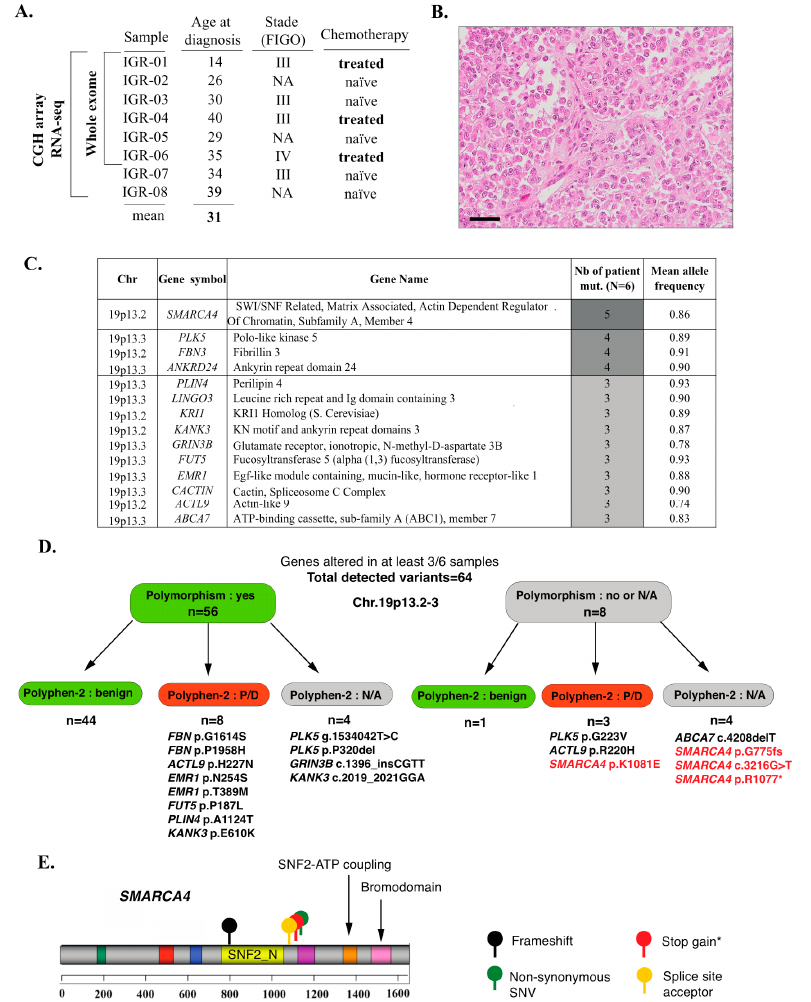
Figure 1. An overview of mutational profiles of SCCOHT. ( A ) Clinical characteristics of the cohort and tests performed. ( B ) Representative histopathology of a SCCOHT case from this cohort (IGR-04), including rhabdoid features; hematoxylin-eosin-saffron, scale bar: 50 μ m. ( C ) Combined analysis of somatic-only and LOH-related alterations: an overview of the 14 genes altered in at least 50% of samples. ( D ) Breakdown of variants detected in the 14 recurrently altered genes, including classification as known polymorphisms (Genome Aggregation Database v.2.1.1) and Polyphen-2 functional prediction scores. N/A: not available. P/D: possibly or probably damaging. The variants for which functional impact cannot be ruled out are explicitly listed. ( E ) Type and localization of the mutations found by WES in the SMARCA4 gene; * indicates that this identical mutation was found in two independent patients. In order to also account for alterations that may be related to an LOH event, we performed a second analysis using the following criteria: mutant allele frequency higher in tumor than in normal